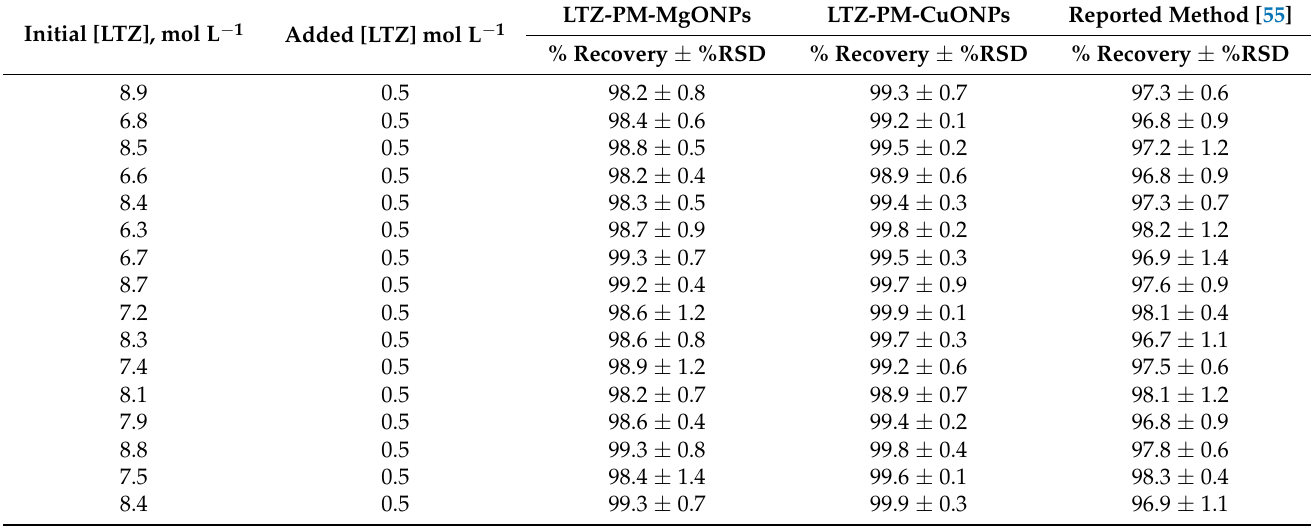
Table 6. The outcomes from the determination of LTZ in biosamples using modified LTZ-PM-MgONPs and LTZ-PM- CuONPs coated wire sensors in comparison with a reported method